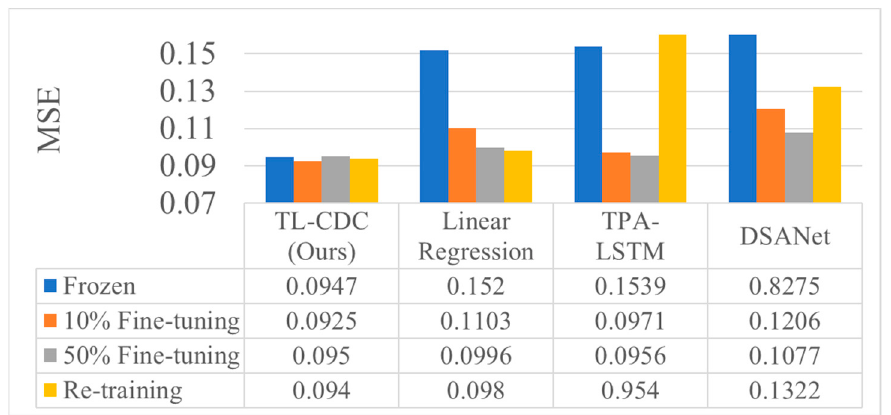
Figure 19. Comparison of TL-CDC and other time series models for predicting the course develop- ment of target disease under k = 3.